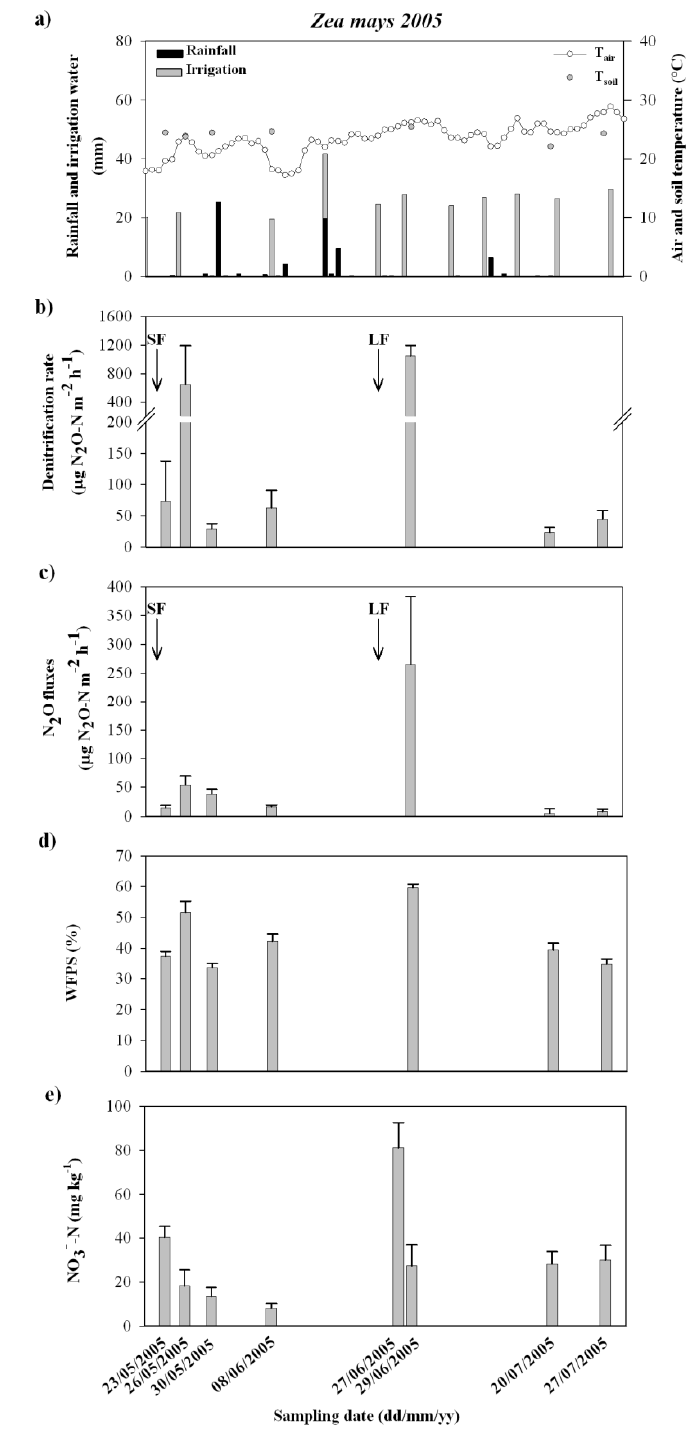
Figure 1. Figure shows: the pattern of climatic variables (daily average air temperature and rainfall, soil temperature and irrigation water input) ( a ) and the mean values and standard errors for denitrification rate ( b ), N 2 O fluxes ( c ), soil water filled pore space (WFPS) ( d ) and soil NO 3 − ( e ), in the course of the Zea mays crop in 2005. SF, sowing fertilization; LF, late fertilization.